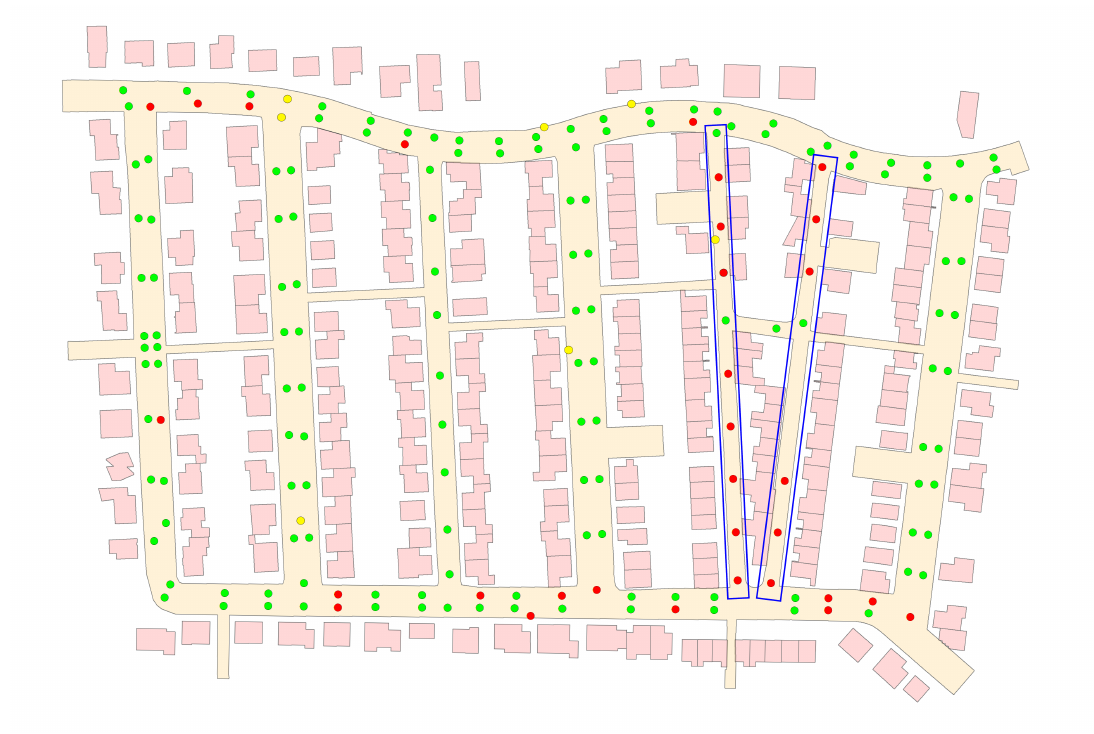
Figure 7. Detection results on testing dataset: correctly detected storm drains (TP) are shown in green, wrongly detected storm drains (FP) are represented by the yellow circles, undetected storm drains (FN) are indicated by the red circles and the blue rectangles display the areas with poor detection performance.